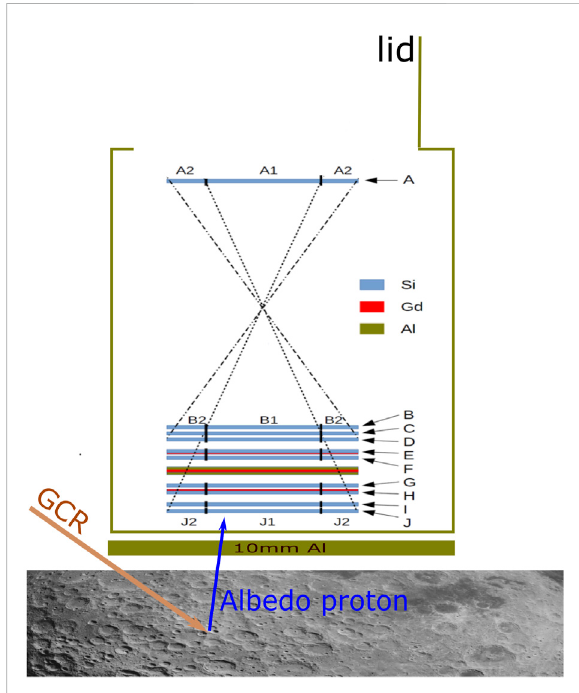
FIGURE 1 Schematic view of the LND sensor head located above the lunarregolithwitha10-mmAlequivalentshielding(olive)between LND and the lunar soil. The LND sensor head consists of 10 segmented 500 μ m-thick Si detectors A – J. The Gd (red) and Al (olive) absorbers are designed to detect uncharged particles. The 10-mm Al sheet is added to mimic the shielding by the material between the sensor head and the lunar soil. On the lunar surface,the interaction of high-energy GCR particles (mainly protons) with the soil generates secondary, upward-moving protons. A more detailed description of LND is given in Wimmer- Schweingruber et al.